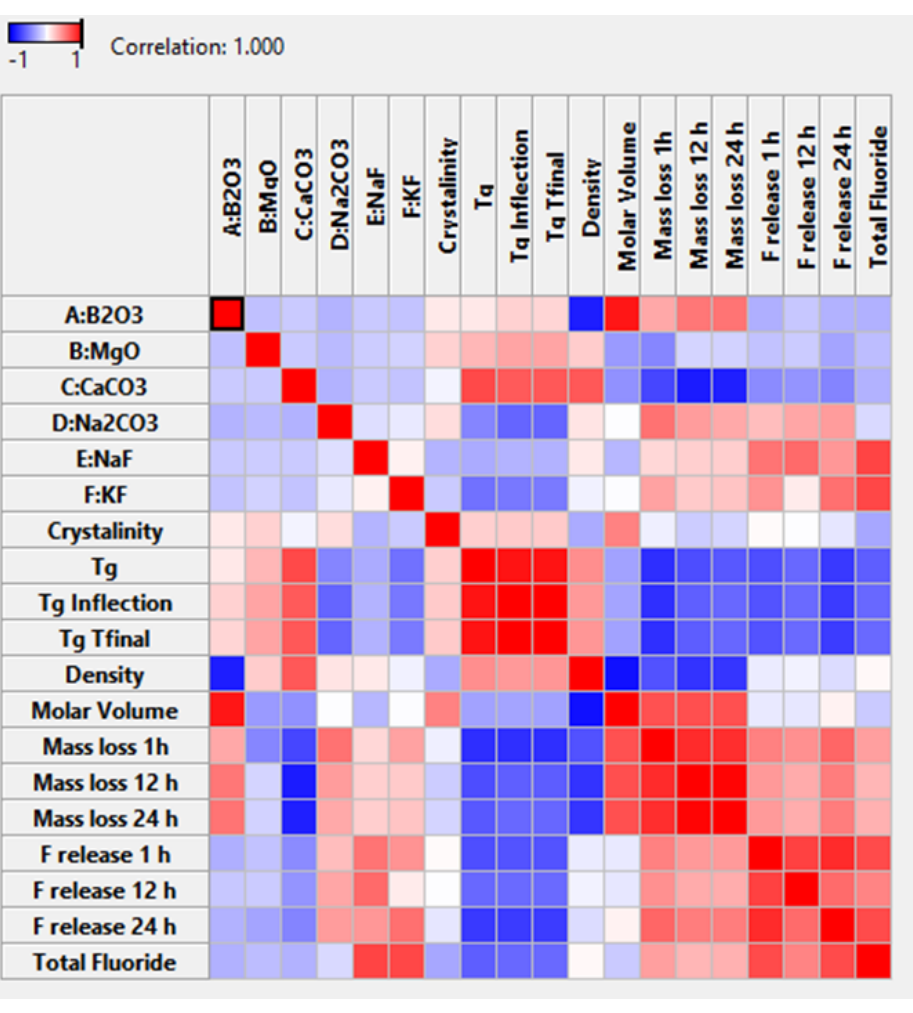
Figure 3. Correlation table visualising the impact of glass components on the measured glass prop- erties with correlations displayed from blue for negative correlations to red for positive correlations.